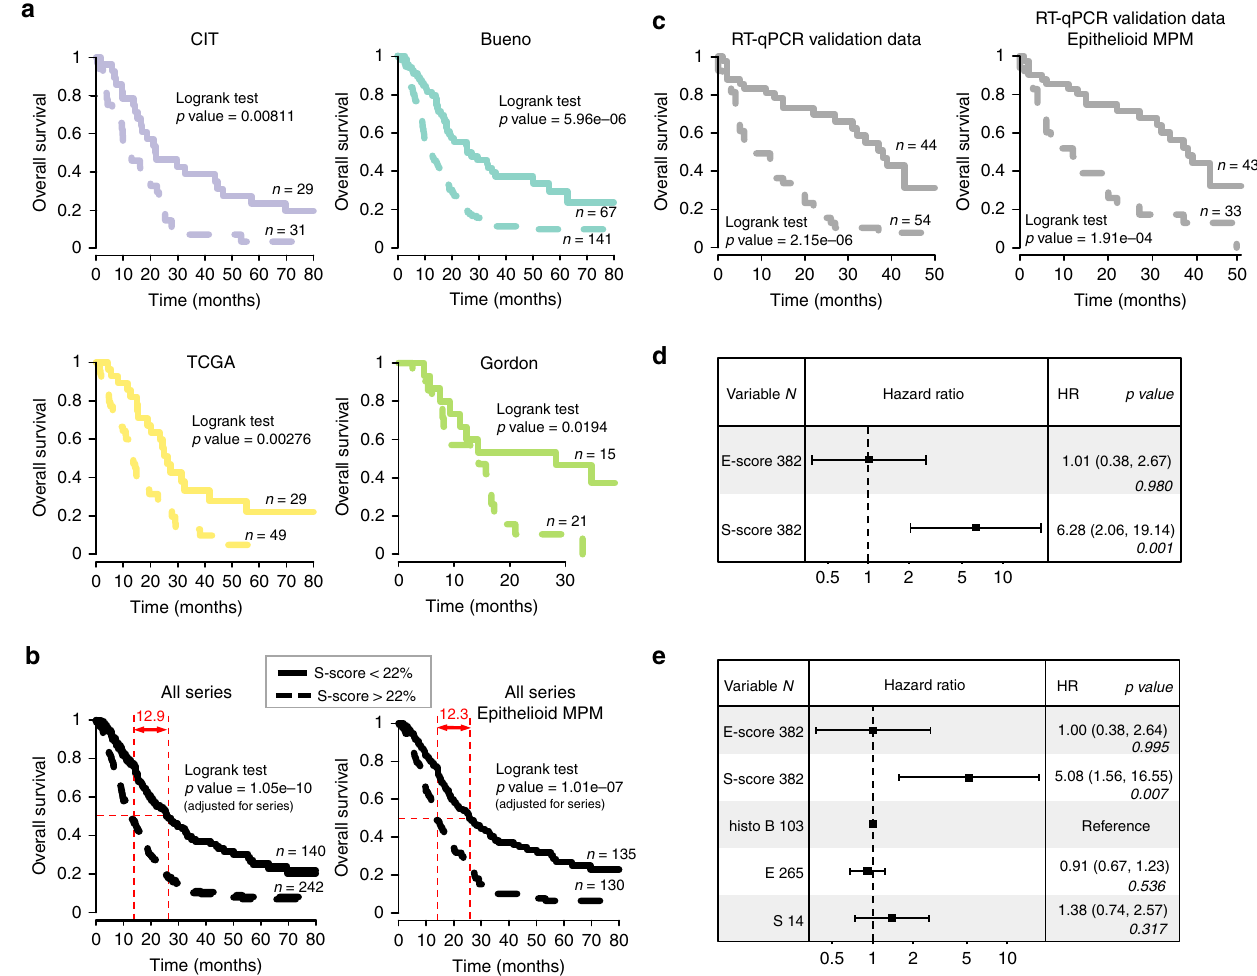
Fig. 3 Prognostic impact of the S -score. Overall survival curve plots for patients with less than 22% of S -score (plain curve) or more than 22% of S -score (dashed curve) in samples in the CIT, Bueno, TCGA, and Gordon series ( a ), all samples from the different series or the series restricted to epithelioid MPM ( b ), and our qRT-PCR validation dataset ( c ). Difference in median overall survival between patients with less or more 22% of S-score is indicated in red ( b ). The P values are based on a log-rank test and adjusted for the series when appropriate, and the number of patients ( n ) is indicated in each condition. d , e Forest plots of the overall survival hazard ratios (HRs) estimated using a multivariate Cox analysis adjusted for the series, integrating the E -score, S - score ( d ) and the histological types ( e ) for MPM samples from the CIT, Bueno, TCGA and Gordon series. The hazard ratios, 95% con fi dence intervals (CIs) and related Wald test P values are given for both